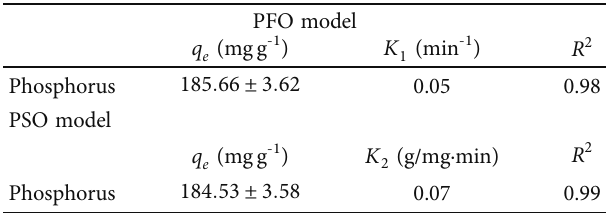
Table 3: Parameters of PFO and PSO adsorption rate